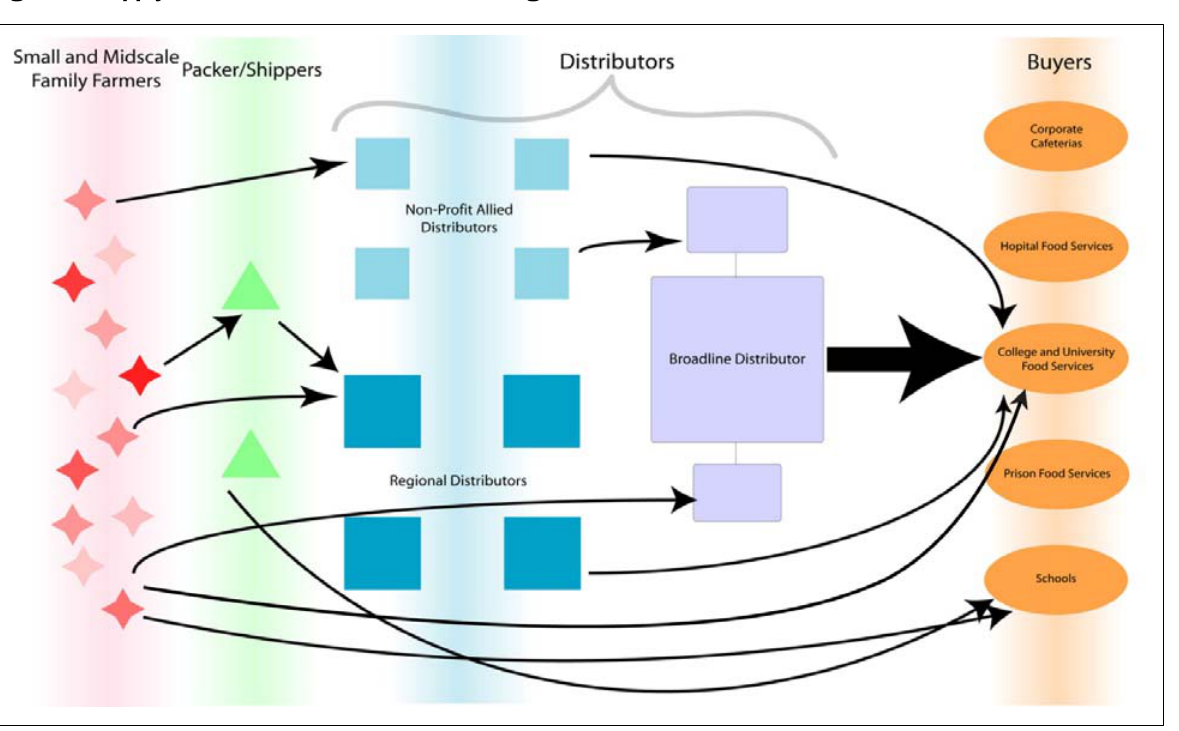
Figure 2. Percentage of Produce Purchased by Food Service Buyers From Different Sources (colors follow from figure 1)